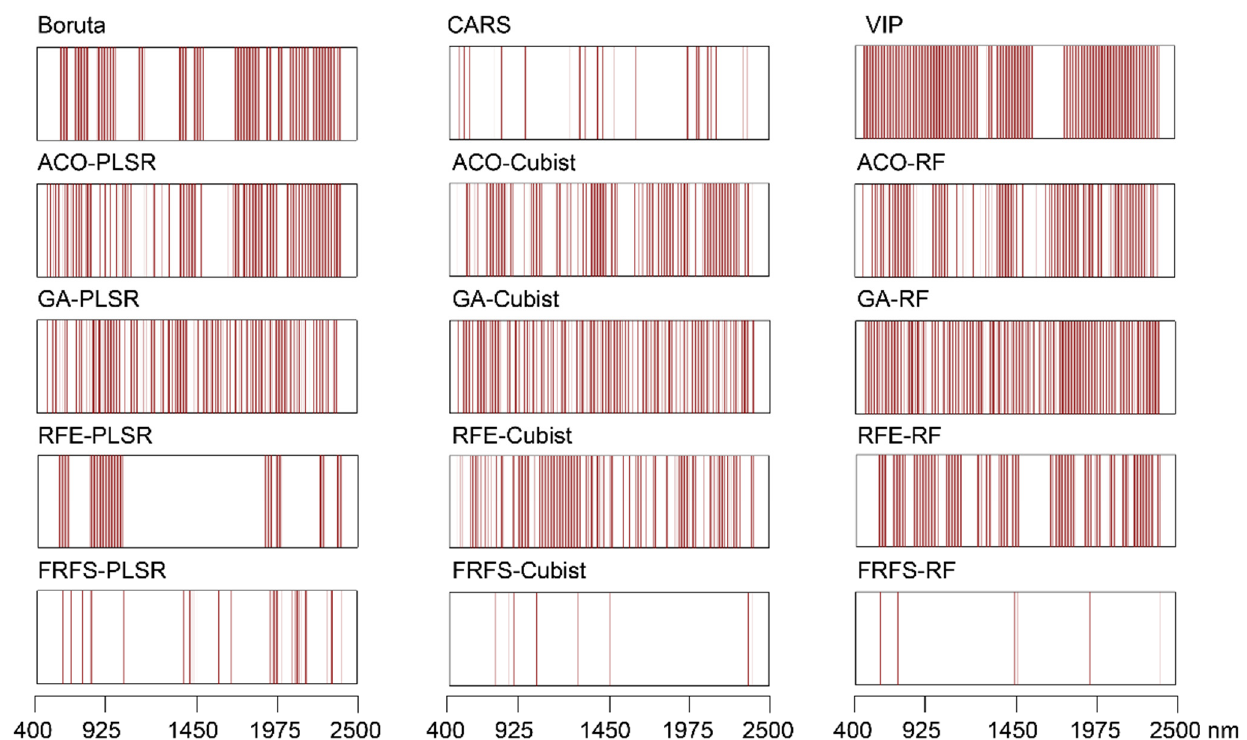
Figure 5. Selected spectral bands by different variable selection algorithms: an example for SOM.